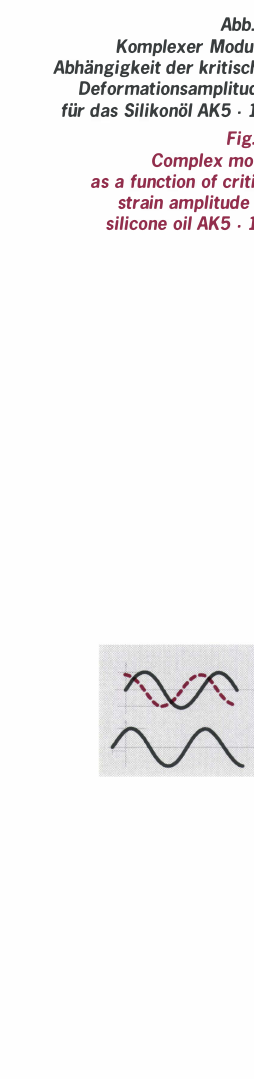
Fig. 9: Linear viscoelastic region of limestone/silicone oil